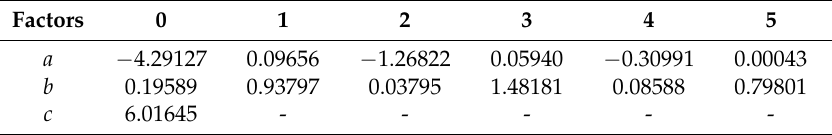
Table 3. Values for a , b and c factors of the df min fit, used to model df min for given kt , kt var , AM, AOD, water vapour and up/down time. The RMS of residuals is 0.0528.